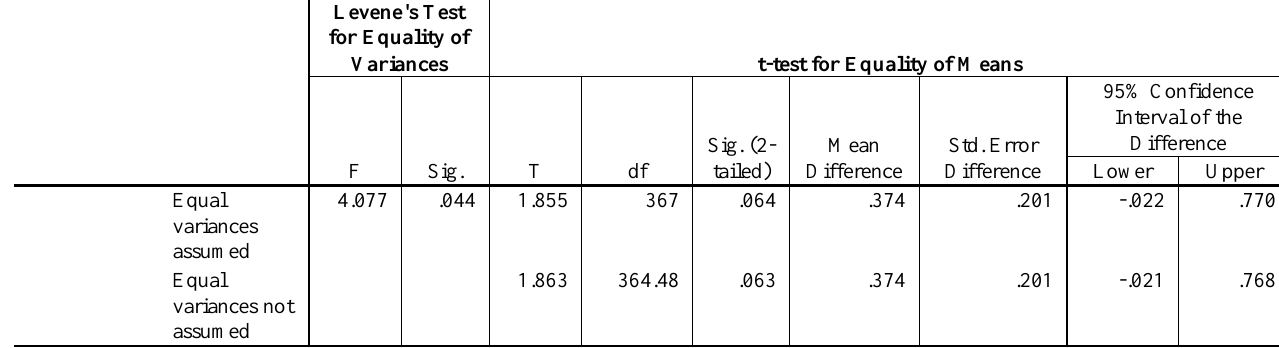
Table 5: Independent samples test for